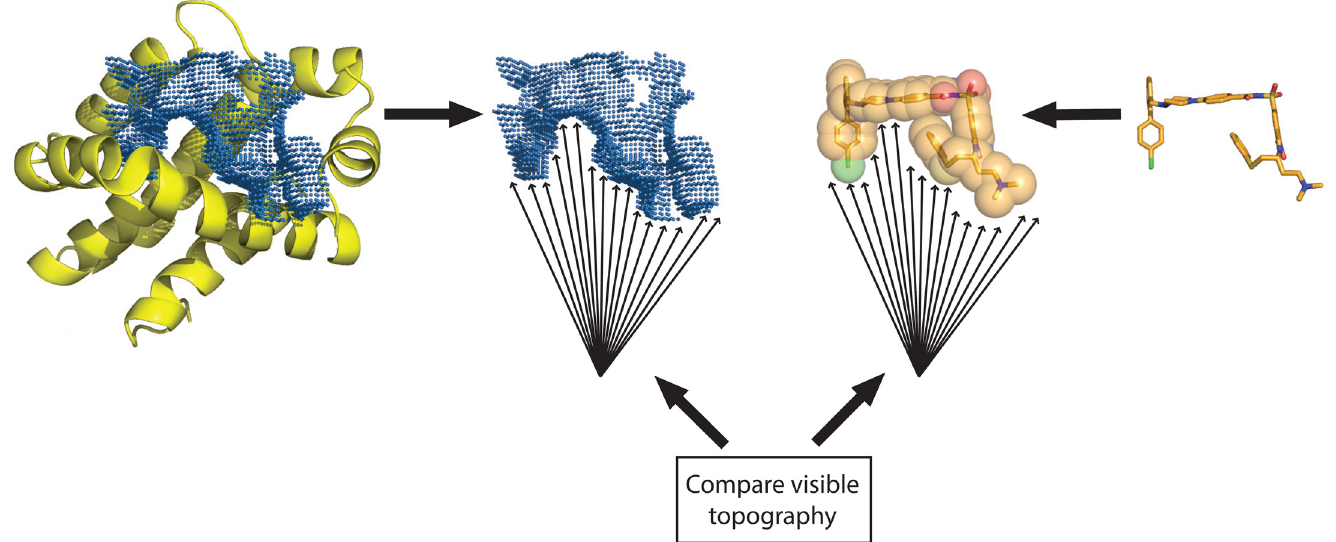
Fig 1. Schematic illustration of the DARC approach. We begin by using a geometry-based method to define the target pocket on the protein surface [24]. Next, we define a series of rays that emanate from a vantage point inside the protein. Collectively, the distance at which these rays reach the protein surface describes the topography of the protein surface in this region, as “ seen ” from this vantage point. If a bound ligand is complementary to the protein surface, its surface topography will “ look ” similar to that of the protein surface when viewed from this vantage point; in other words, each ray will intersect the ligand at similar distance as its intersection with the protein